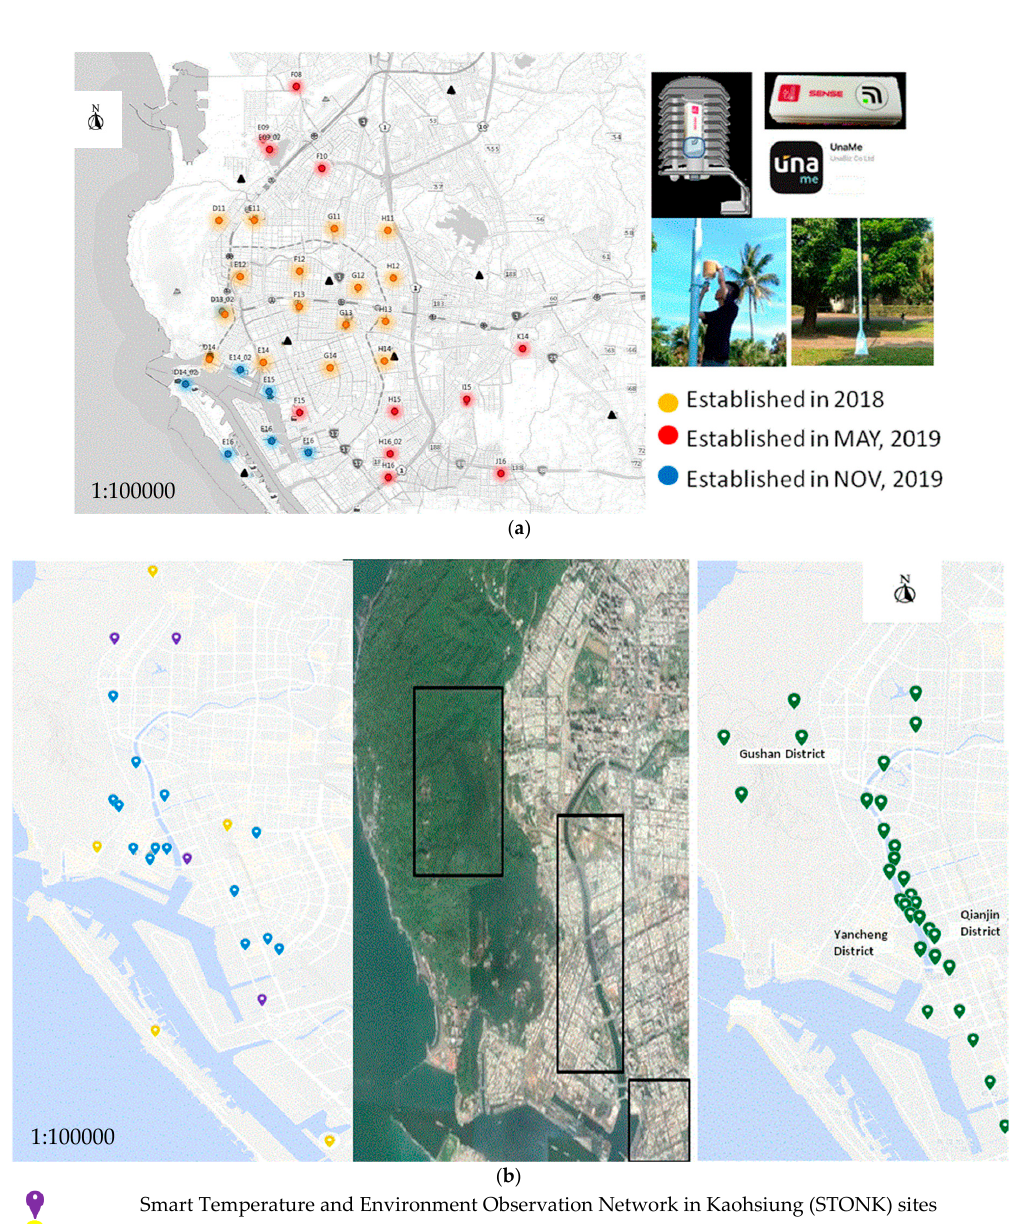
Figure 3. ( a ) Layout of the 34 STONK sites (Source: Xiao-Qing Guo). ( b ) Monitoring stations.